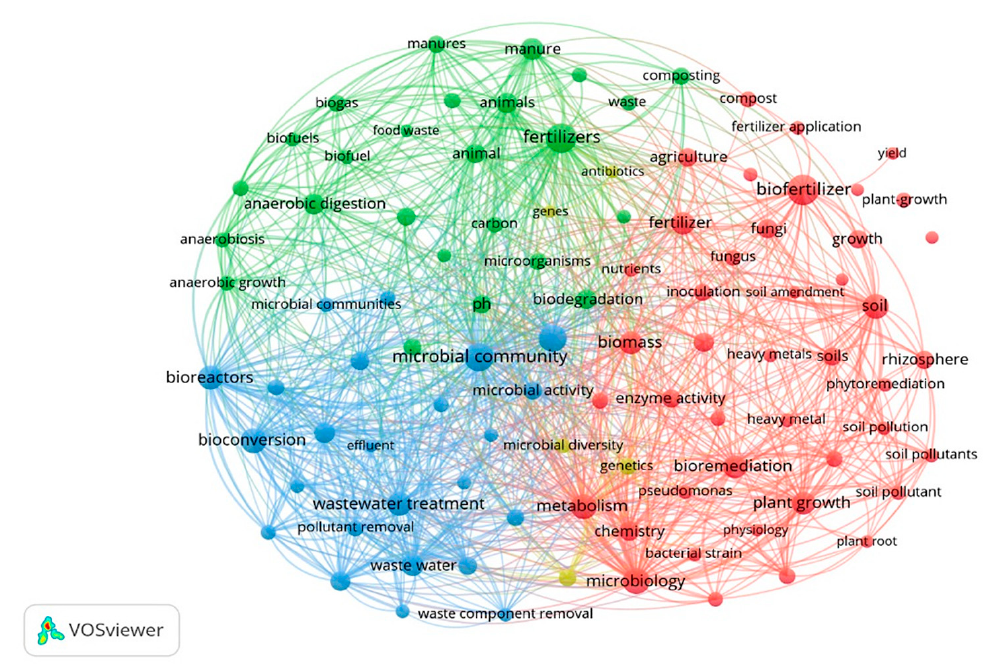
Figure 5. Graphical representation of co-occurrence mapping of relevant keywords associated with fertilizer research.